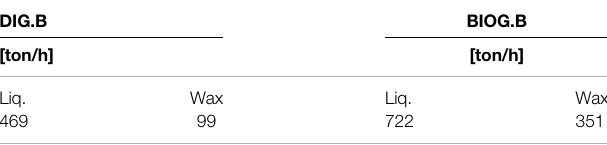
TABLE 3| Potential production ofFT compounds utilizing biogas plants ’ CO 2 and digestate fl ows. The liquid fraction accounts for both naphtha and middle distillate cuts.